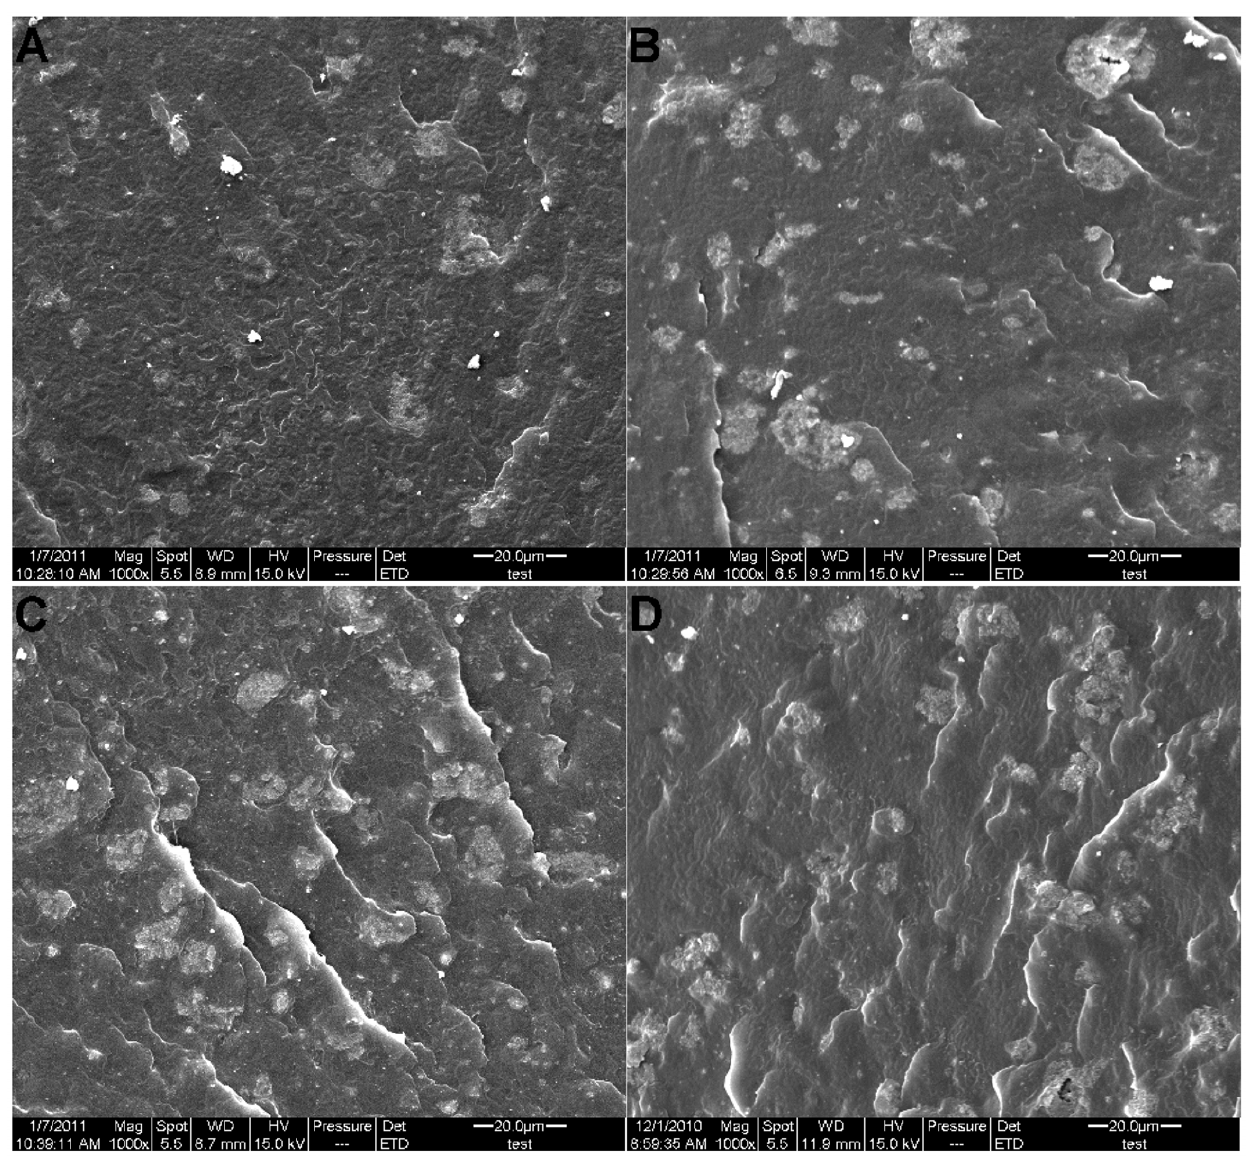
Figure 8. SEM images of the fractured surface for the composites. A: S-Ni 0.1 MgAl-La/EVA, B: S-Ni 0.1 MgAl-Ce/EVA, C: S-Ni 0.1 MgAl-Nd/EVA and D: S-Ni 0.1 MgAl/EVA. doi:10.1371/journal.pone.0037781.g008 indicate that S-Ni 0.1 MgAl-La has the best flame retardant efficie ncy, while S-Ni 0.1 MgAl-Nd shows the least flame retardancy.